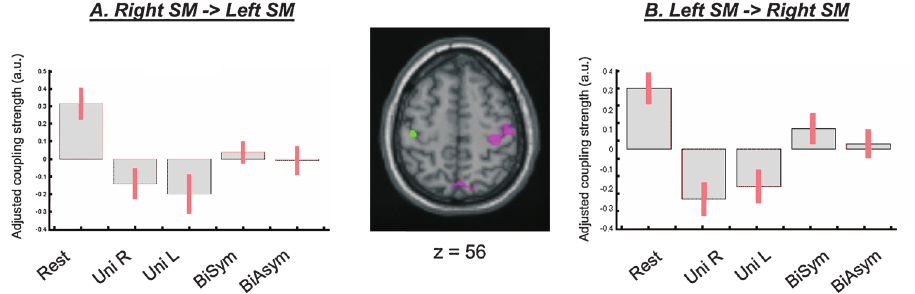
Figure 6. Inter-hemispheric connectivity between the two SM-regions. Direct comparisons between passive movement conditions demonstrated that the coupling between the left and the right SM-regions was higher during bimanual than unimanual conditions. The central panel shows the anatomical localization of the coupling effects (magenta, PPI seeded in the left SM and revealing coupling with the right SM; green, PPI seeded in the right SM and revealing coupling with the left SM). The signal plots display the coupling parameters for each condition ( panel A : parameters estimates in the left SM; panel B : parameters in the right SM; in arbitrary units, (cid:2) 90% confidence intervals). The highest connectivity was observed during Rest (bar 1; cf. also Table 2 ), but coupling between SM-regions was also greater during bimanual than unimanual conditions (compare bars 4 and 5 vs. bars 2 and 3). Note that the coupling parameters are mean-adjusted (mean equal zero), the actual values of the coupling parameters were 1.27, 0.80, 0.68, 0.99, 0.92, for the left SM-region; and 1.33, 0.77, 0.83, 1.12, 1.05, for the right